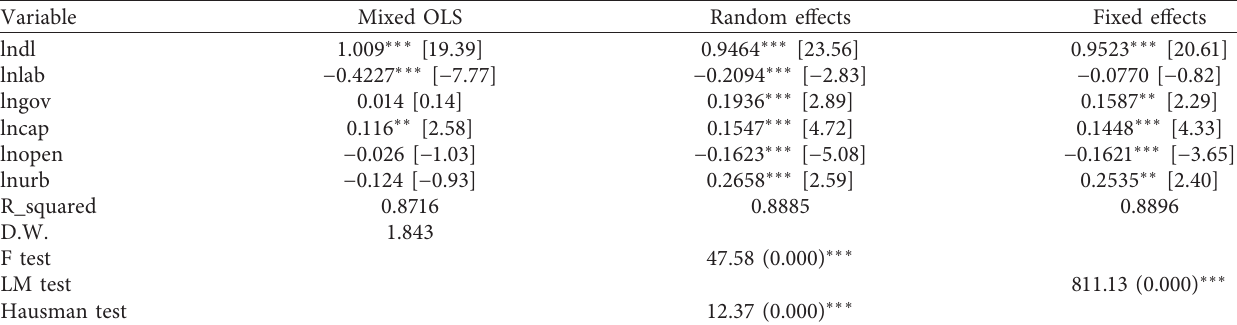
Table 4: Estimation results of nonspatial panel data.